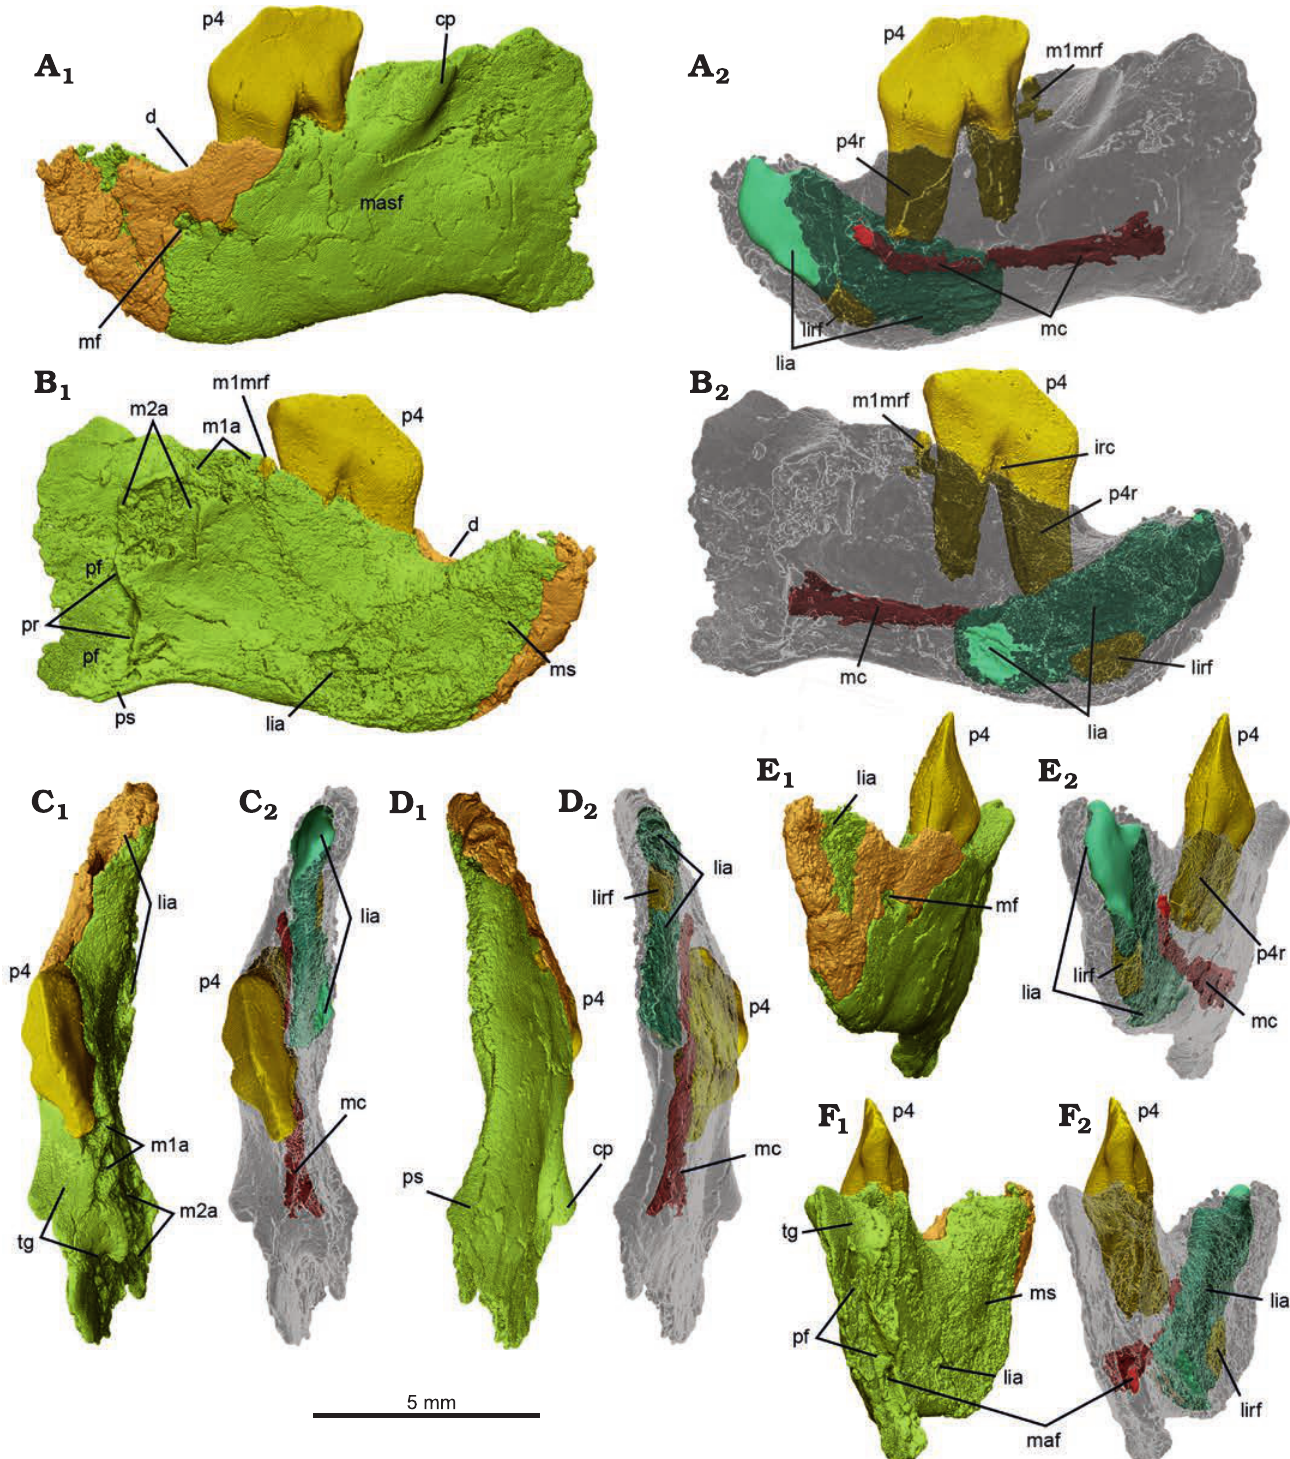
Fig. 4. MicroCT scans of left dentary with p4 in situ, NMV P252730, of the cimolodontan multituberculate Corriebaatar marywaltersae Rich, Vickers- Rich, Flannery, Kear, Cantrill, Komarower, Kool, Pickering, Trusler, Mor ton, van Klaveren, and Fitzgerald, 2009, Flat Rocks locality, Eumeralla Formation, Barremian, Lower Cretaceous of Victoria, Australia. The two parts (anterior fragment in brown, posterior fragment in lime green) that compose the specimen, in lateral (A), medial (B), dorsal (C), ventral (D), anterior (E), and posterior (F) views, with dentary semi-transparent in A 2 –F 2 . Abbreviations: cp, coronoid process; d, diastema; irc, interradicular crest; lia, lower incisor alveolus (turquoise); lirf, root fragment (dark yellow) in lower incisor alveolus; m1a, lower first molar alveoli; m1mrf, root fragment (dark yellow) in mesial alveolus of m1; m2a, lower second molar alveoli; maf, mandibular foramen; masf, masseteric fossa; mc, mandibular canal (deep red); mf, mental foramen; ms, mandibular symphysis; p4, lower fourth premolar (bright yellow); p4r, lower fourth premolar root (dark yellow); pr, pterygoid rim; pf, pterygoid fossa; ps, pterygoid shelf; tg, temporal